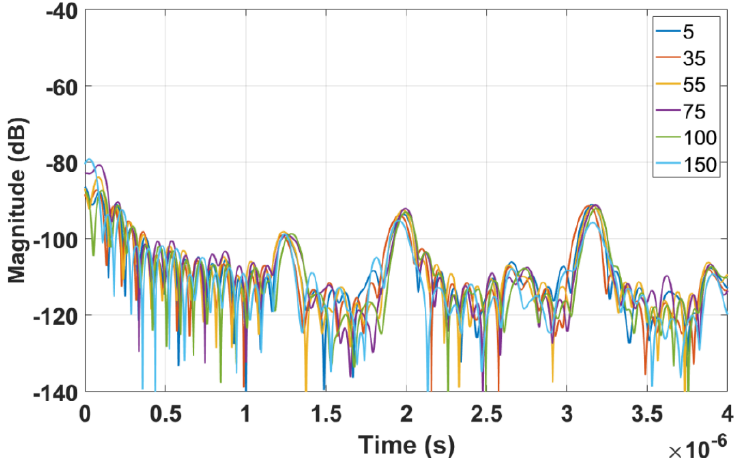
Figure 14. Time domain response from LimeSDR−mini data after compensation of the free space propagation loss, antennas’ reflection loss, and antennas’ near−field coupling.